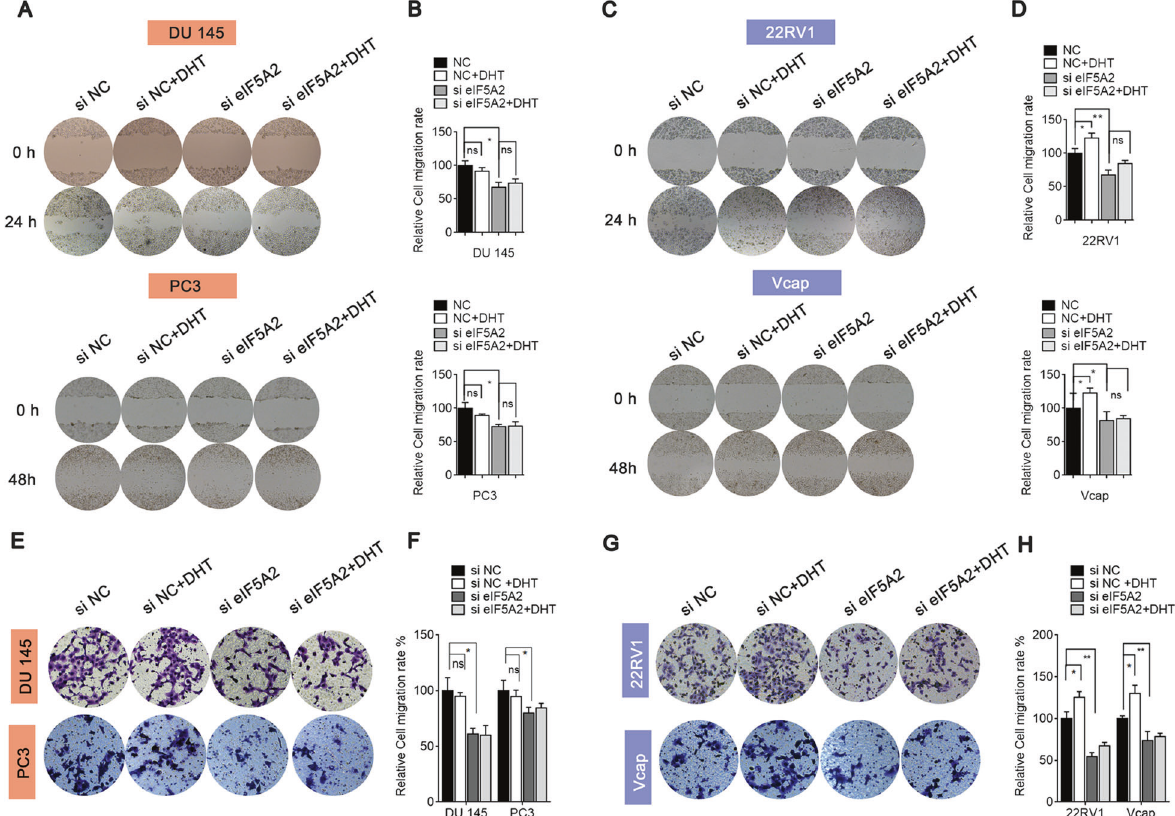
Fig. 4 Effect of eIF5A2 on cell migration and invasion in the presence of DHT. A , B Migration of DU145 and PC3 cells transfected with eIF5A2 siRNA or negative siRNA in the presence or absence of DHT. C , D Migration of 22RV1 and Vcap cells transfected with eIF5A2 siRNA or negative siRNA in the presence or absence of DHT. E – H Invasion of PCa cells transfected with eIF5A2 siRNA or negative siRNA in the presence or absence of DHT. (NS no signi fi cance versus eIF5A2 siRNA; * P < 0.05, ** P < 0.01).